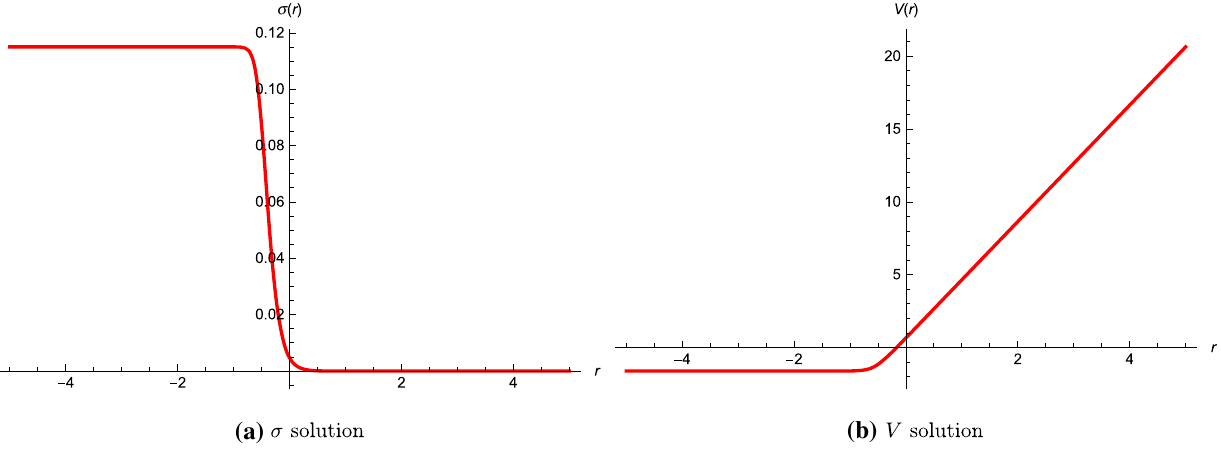
Fig. 15 An RG flow from SO ( 4 ) N = ( 1 , 0 ) SCFT in six dimensions to two-dimensional N = ( 2 , 0 ) SCFT with SO ( 2 ) R symmetry dual to AdS 3 × CH 2